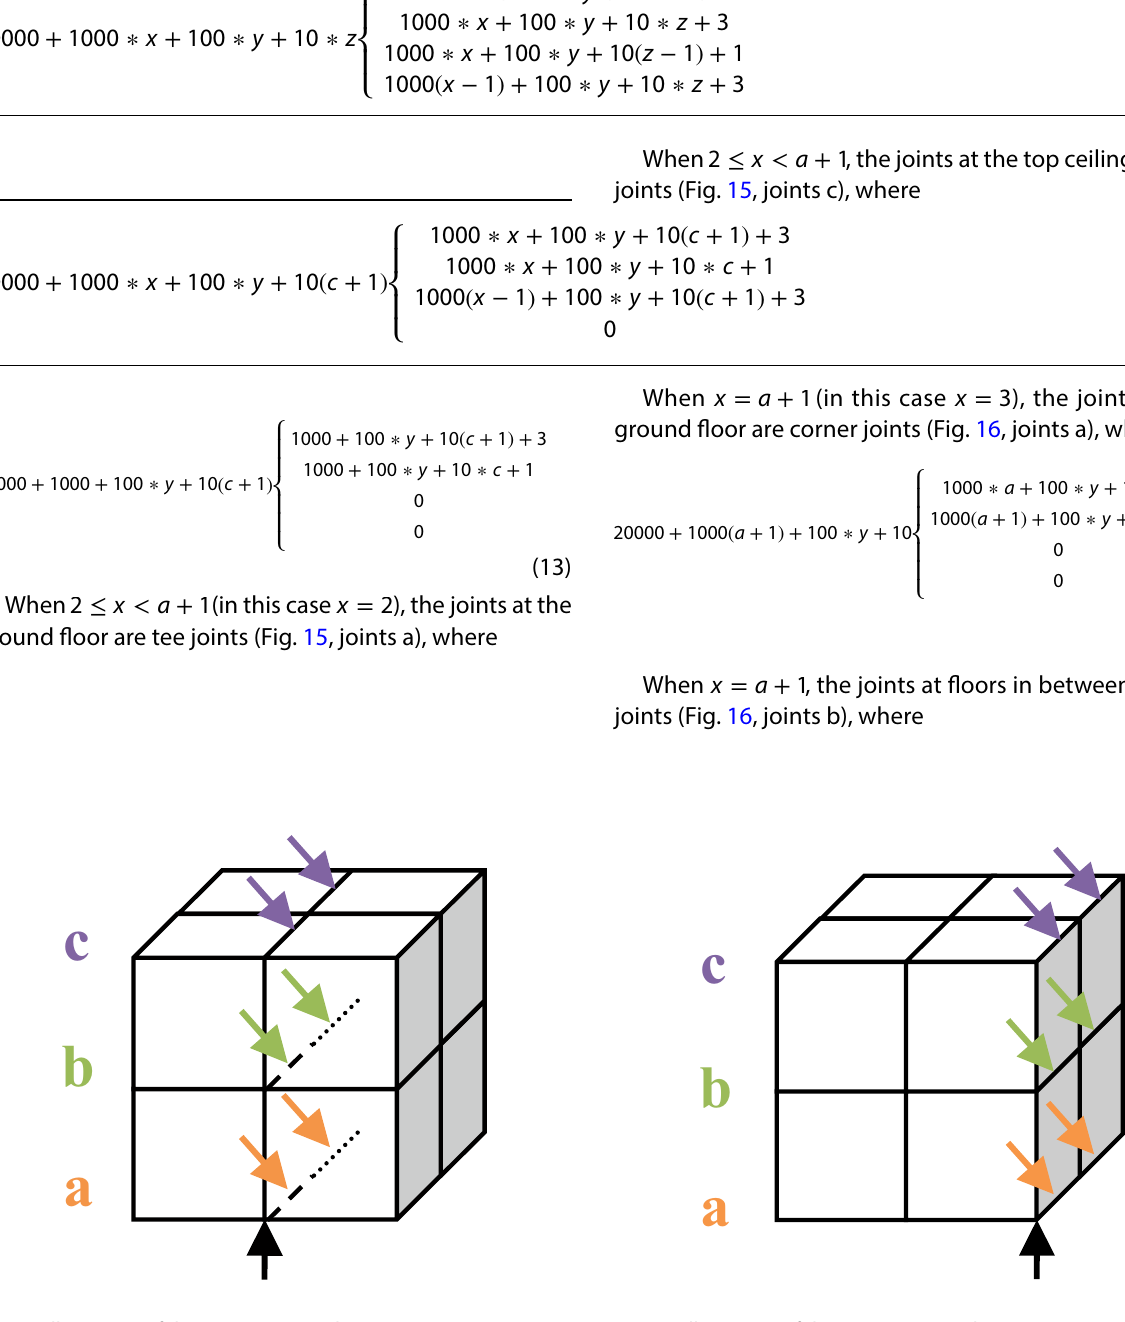
Fig. 15 Illustration of the Joint-Y joints when 2 ≤ x < a + 1 Fig. 16 Illustration of the Joint-Y joints when x = a +